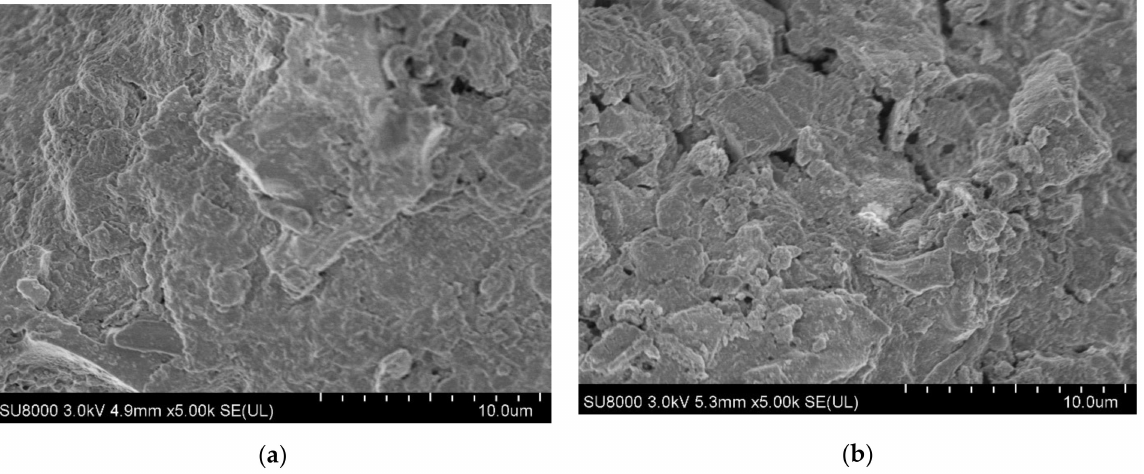
Figure 2. FE-SEM images of the activated biochar-manure compost pellets made of ( a ) rice hulls (ARP); ( b ) palm bark